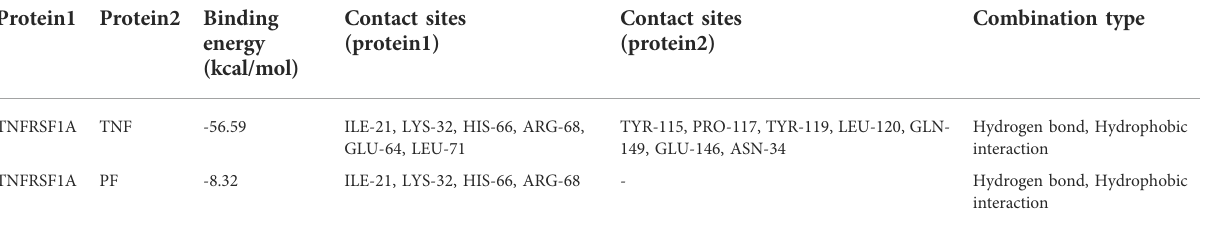
TABLE 5 The molecular docking results of target proteins. Protein1 Protein2 Binding energy